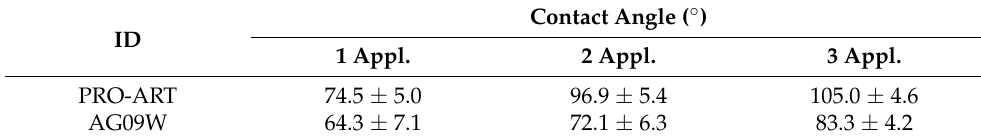
Table 3. Contact angle measurements.